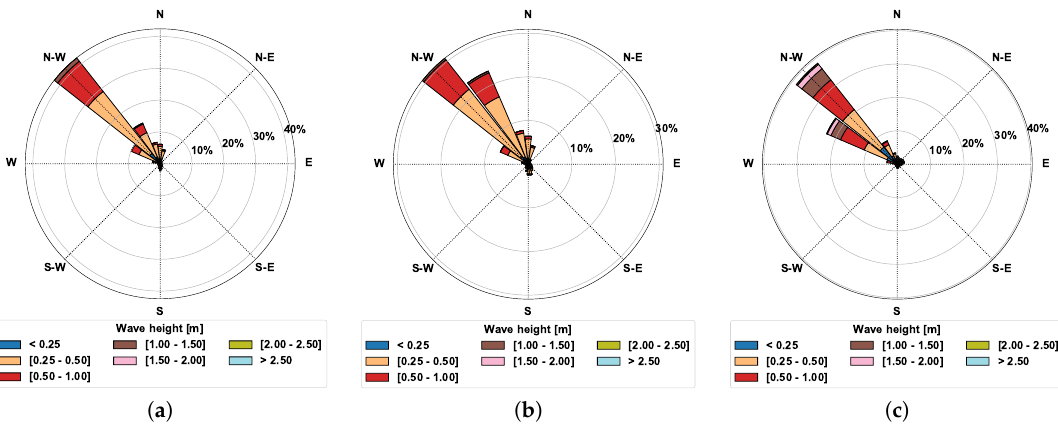
Figure 10. NOAA wave rose at the north node ( a ), NOAA wave rose at the south node ( b ), and ECMWF ( c ) wave rose in proximity of the ADM ins .